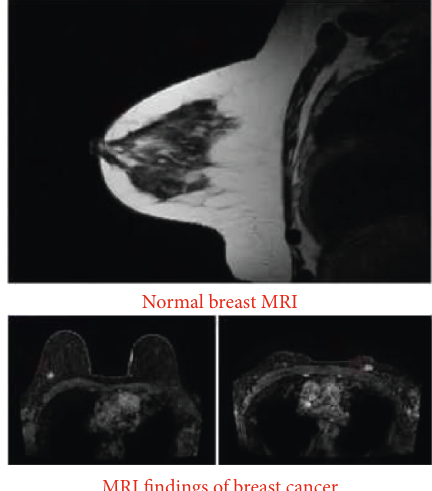
Figure 7: Plot of MRI images of sick patients compared with MRI images of healthy